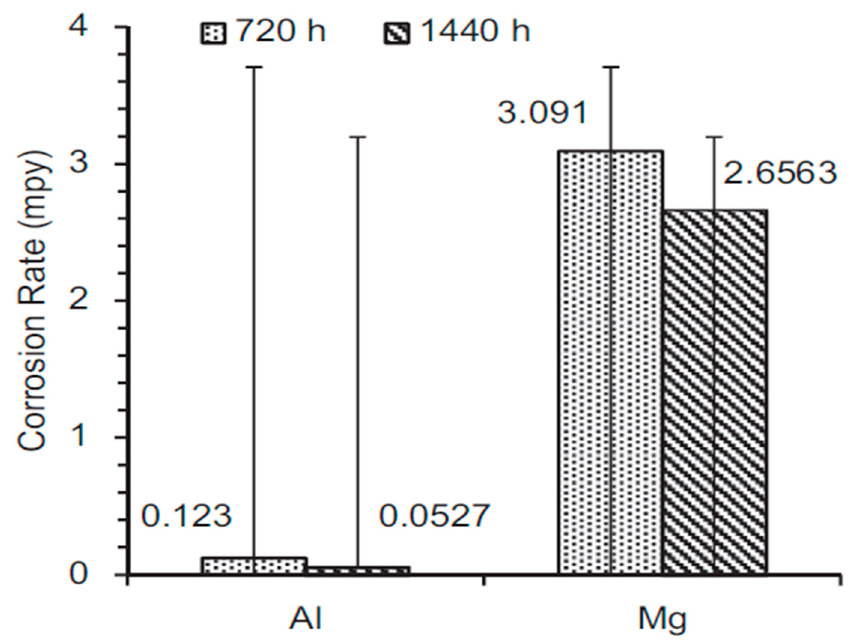
Figure 5. Corrosion rates of magnesium and aluminum at 720 and 1440 h [68].